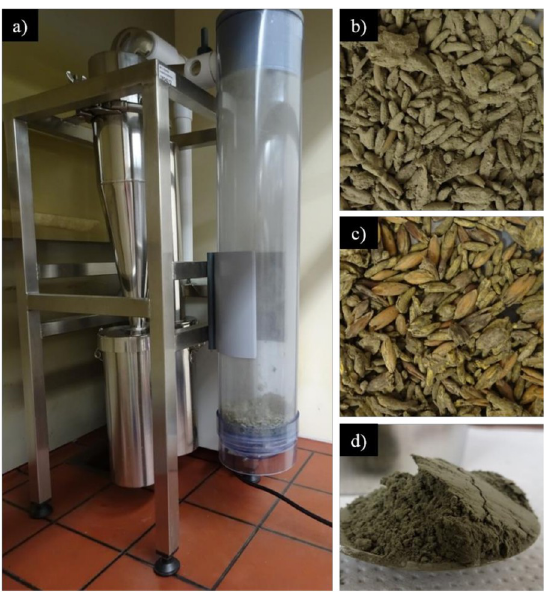
Fig 2. Mycoharvester 1 System. Mycoharvester 1 equipment, version 5b (a); substrate colonized by Metarhizium anisopliae before (b) and after harvest (c); pure conidia of Metarhizium anisopliae (d).